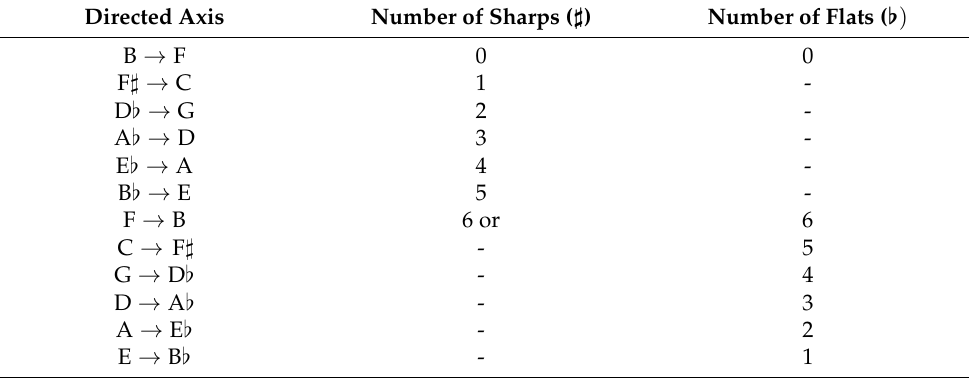
Table 2. The key signatures (sharps and flats) associated with the directed axes inscribed in the circle of